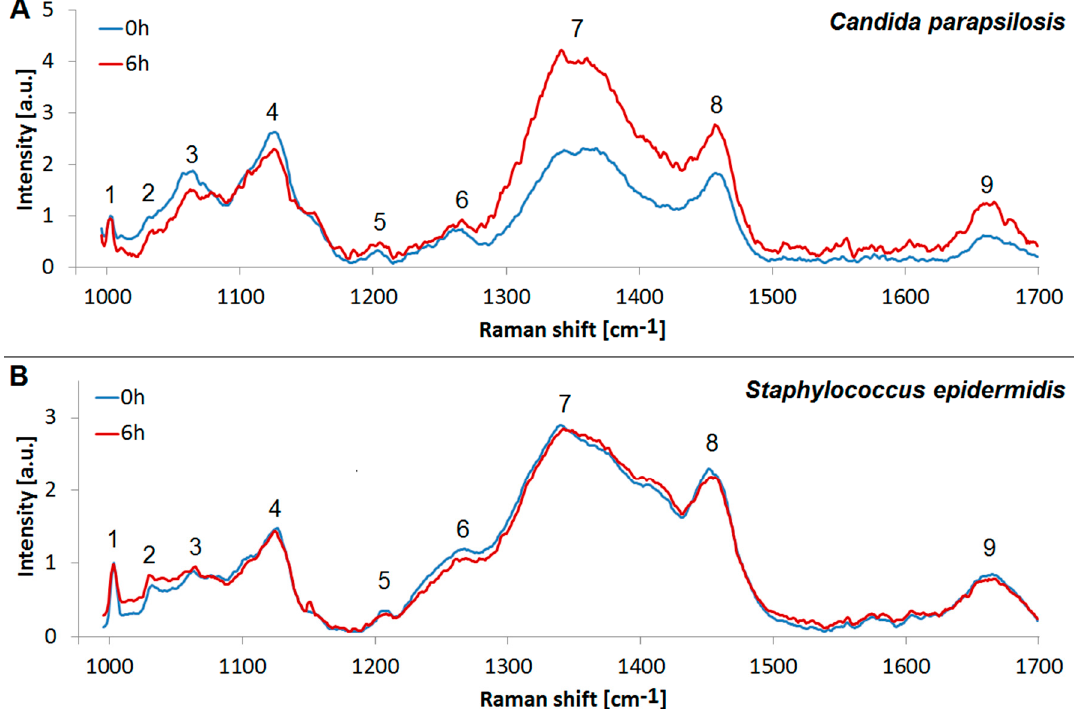
Figure 5. Raman spectra of biofilms. ( A ): Candida parapsilosis ; ( B ): Staphylococcus epidermidis . Comparison of the freshly inoculated substrates containing no ECM (0 h, blue) with 6 h old biofilm, showing the start of the ECM production (6 h, red). The Raman peaks associated with biomolecules are numbered, see Table 2 for the assignments. The spectra were averaged from six separate measurements. Table 2. Assignments of Raman peaks of C. parapsilosis and S.epidermidis biofilms [51].